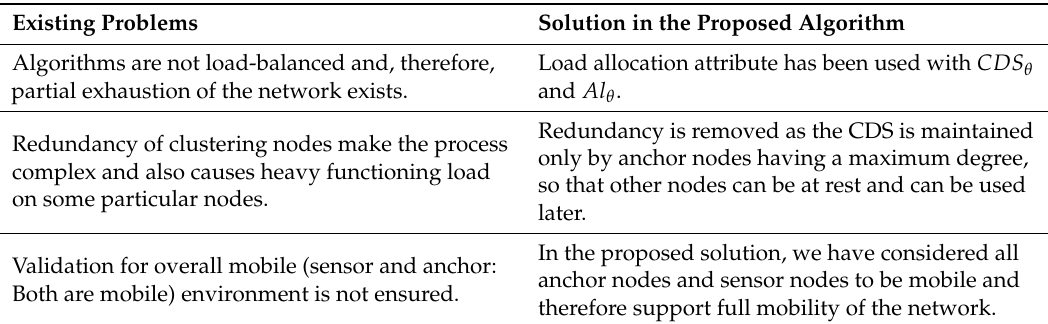
Table 1. Addressing problem with proposed solution.